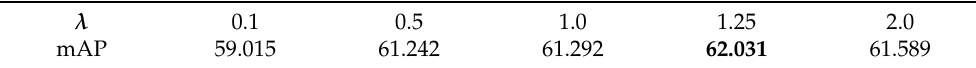
Table 1. Test results of different λ on the DOTA validation dataset (468 images).